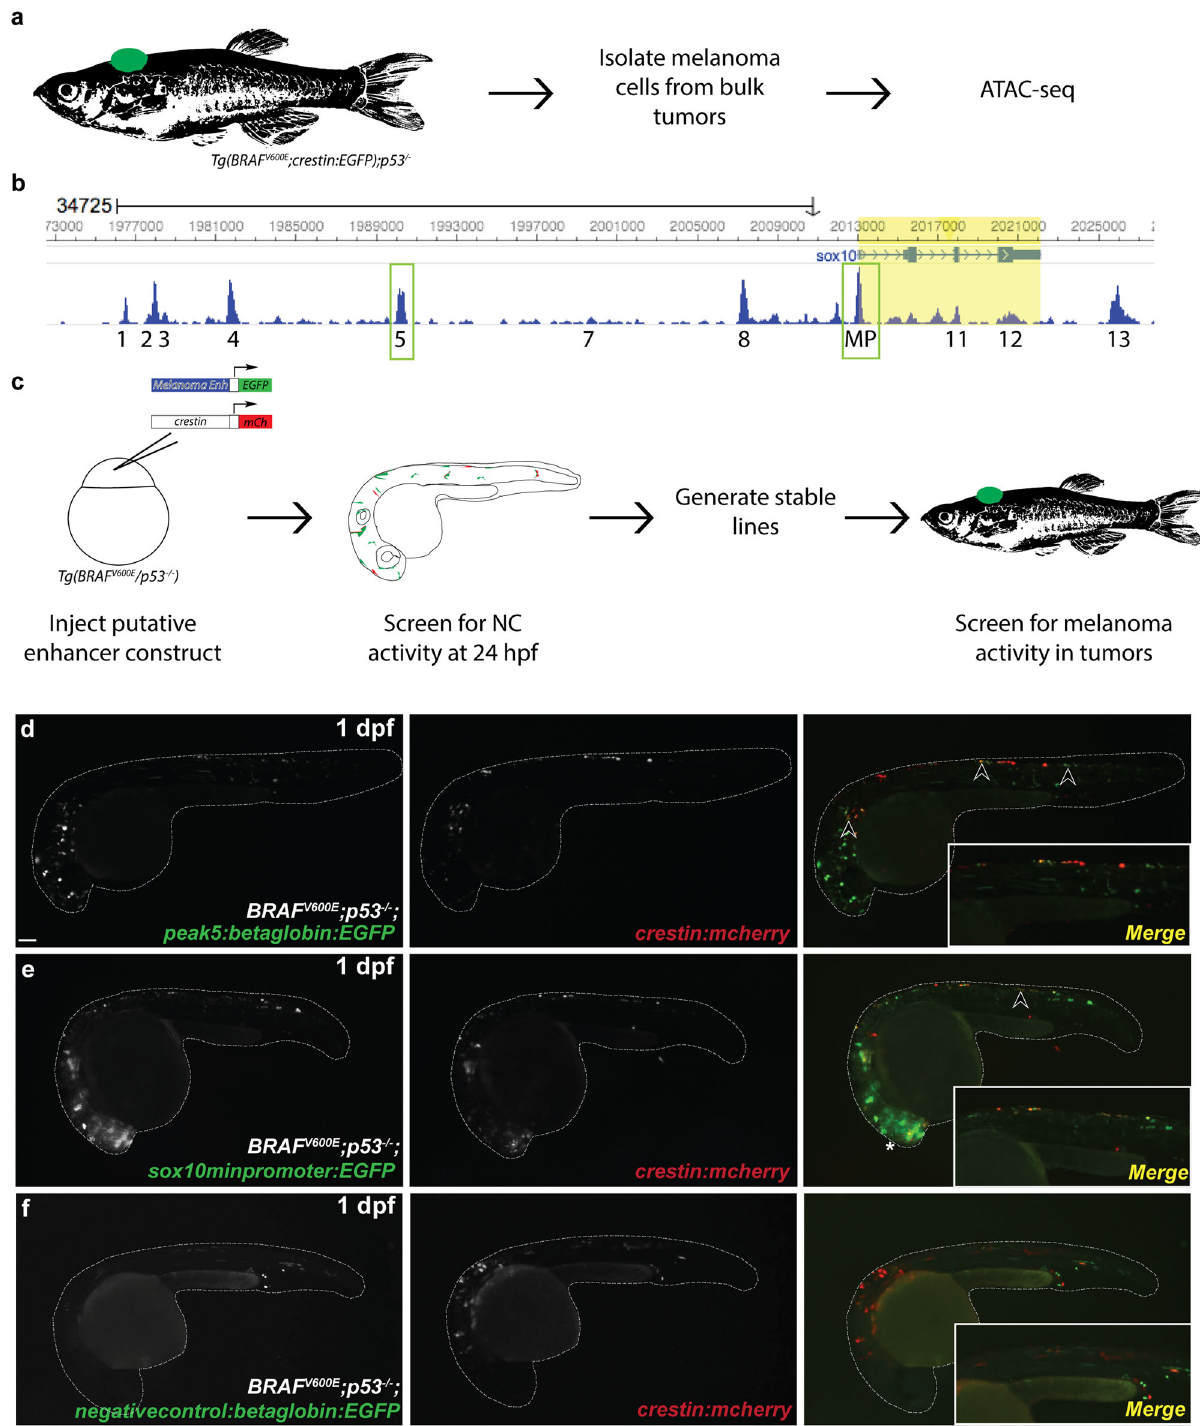
Fig. 1 ATAC-Seq of zebra fi sh melanoma tumors identi fi es peak5 as an active neural crest enhancer. a Schematic for obtaining zebra fi sh melanoma tumor cells for ATAC-Seq. b Regions of open chromatin surrounding the sox10 locus. Peak numbers are annotated below. MP minimal promoter. c Schematic for screening putative enhancers for activity in NCCs and melanoma. d peak5- driven EGFP expression is mosaically present in NCCs (arrowheads) in F0 injected embryos, as indicated by co-localization with crestin:mch at 1 dpf. e The sox10 minimal promoter in F0 embryos is active in both NCCs (arrowheads) and the CNS (asterisk). f F0 embryos injected with a negative control (~76 kb upstream of the sox10 TSS) exhibit only limited expression of EGFP not localized to NCCs. Insets show enlarged region above yolk